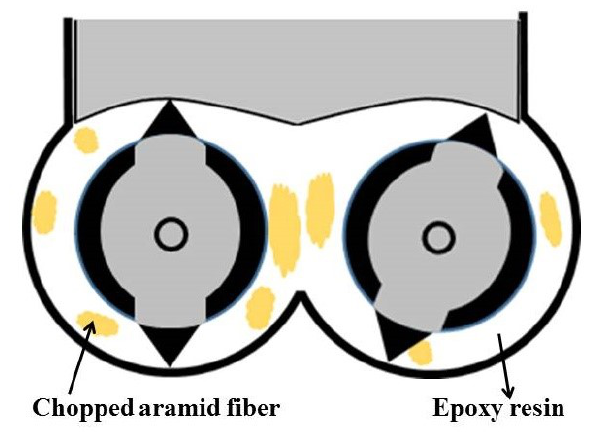
Figure 1: Simulated diagram of hybrid